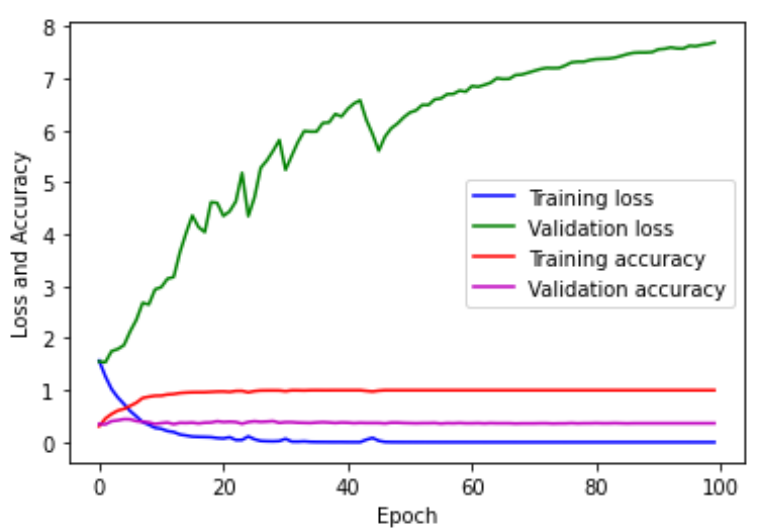
Figure 11. Loss and accuracy plot for the concatenated intensity – phase (IP) image dataset.